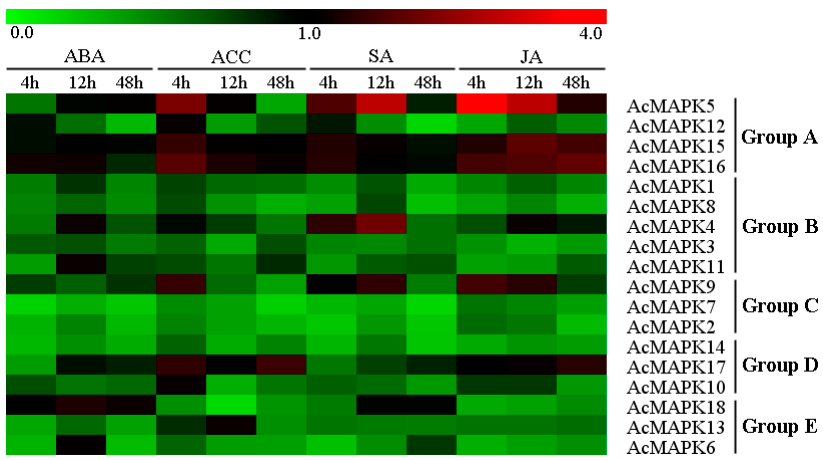
Figure 4. Hierarchical clustering of the expression profiles of AcMAPK genes in response to different hormones treatments in kiwifruit leaves. ABA: treatments with abscisic acid, ACC: treatments with 1-Aminocyclopropanecarboxylic Acid, SA: treatments with salicylic acid; JA: treatments with jasmonic acid, details of the treatments are reported in Materials and Methods. The heat-map demonstrates the relative fold-change expression for all AcMAPK genes in response to the different hormone treatments in comparison to their respective controls. Red and green colors represent increased or decreased expression levels, respectively, in comparison to controls, as reported by the scale. Genes were clustered according to phylogenetic relationships in expression profiles. Relative expression values for each gene and each treatment are provided in Figures S4 and S5.